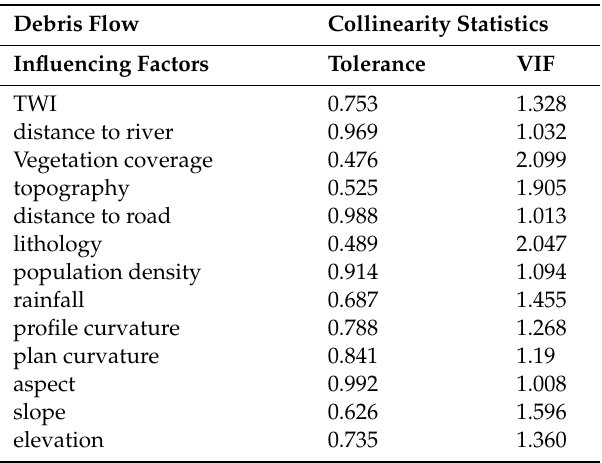
Table 4. The results of multicollinearity analysis.